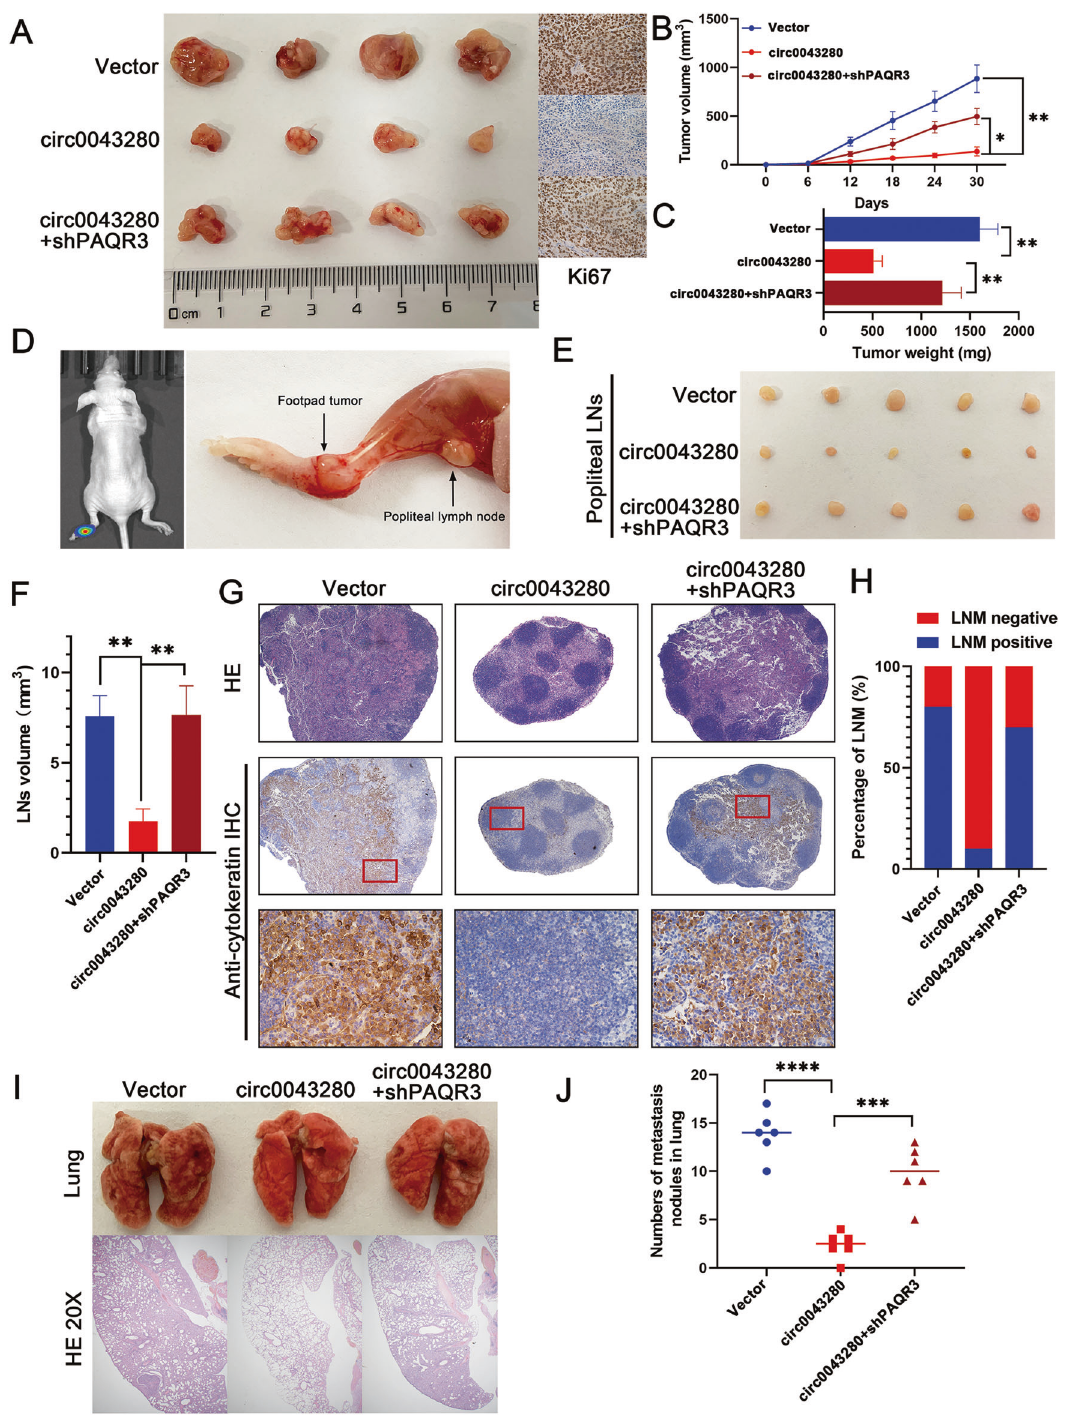
Fig. 5 Hsa_circ_0043280 suppresses tumor growth and metastasis in CCa via a mechanism involving PAQR3 in vivo. A Representative images of dissected tumors from nude mice transplanted with stable hsa_circ_0043280 overexpression or hsa_circ_0043280 overexpression/ PAQR3 knockdown cells. B Subcutaneous tumor growth curves of mice in different treatment groups. C The mean weight of tumors upon sacri fi ce in the experimental groups. D Representative images of the nude mouse model of popliteal LN metastasis. The indicated CCa cells were injected into the footpads of the nude mice, and the popliteal LNs were enucleated and analyzed. Representative images of enucleated popliteal LNs ( E ) and histogram analysis of the LN volume ( F ) in the indicated cells. G Representative images of HE and IHC as indicators of LN status. Original magni fi cation, × 40 for HE and IHC, × 100 (Red). H Quanti fi cation of popliteal LN metastasis in the indicated groups. Representative images of HE staining of the lungs ( I ) and the number of nodules showing lung metastasis ( J ) in the tail-vein injection nude mice model undergoing different treatments. Original magni fi cation, × 20. Each experiment was performed at least three times independently. * P < 0.05; ** P < 0.01; *** P < 0.001; **** P < 0.0001.